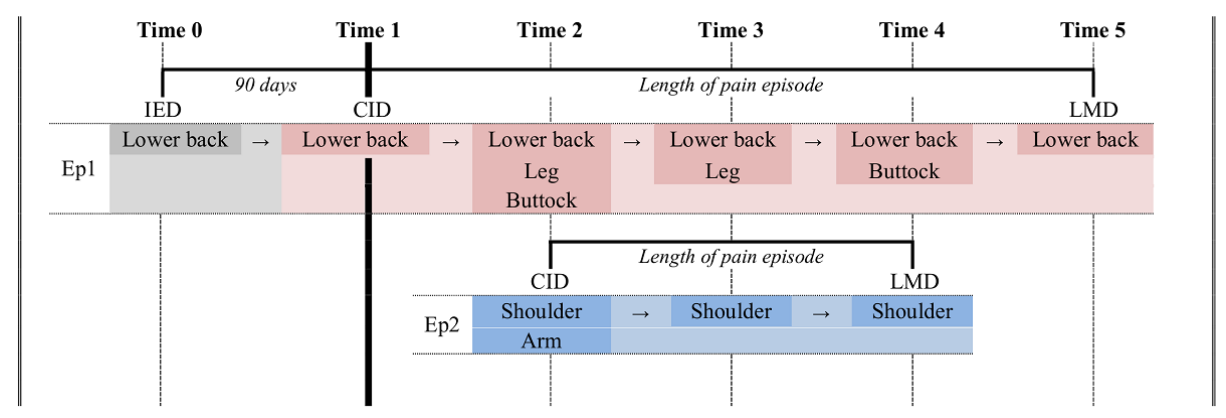
Figure 2. Conceptual representation of a patient’s two chronic pain episodes that unfolded in parallel. Note that the even time intervals are a simplified illustration; the real events have varying intervals. CID: chronic pain index date; Ep1: episode 1; Ep2: episode 2; IED: initial event date; LMD: last mention